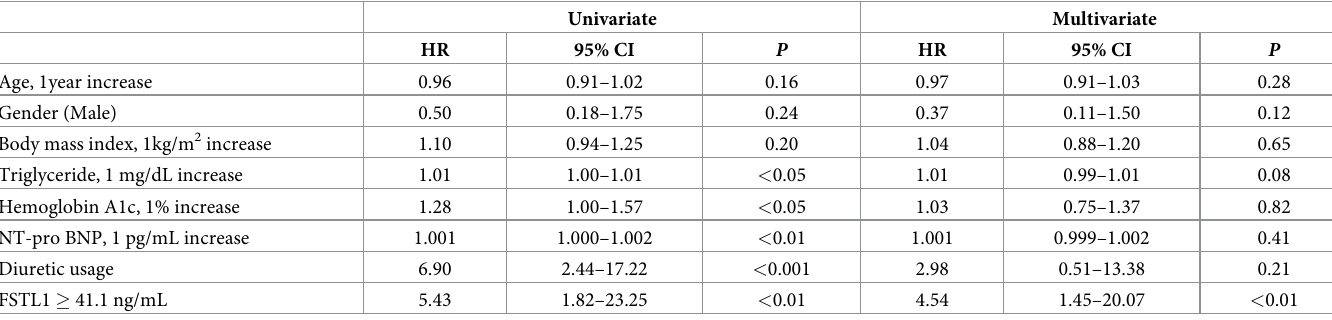
Table 4. Multivariate cox proportional hazard models for